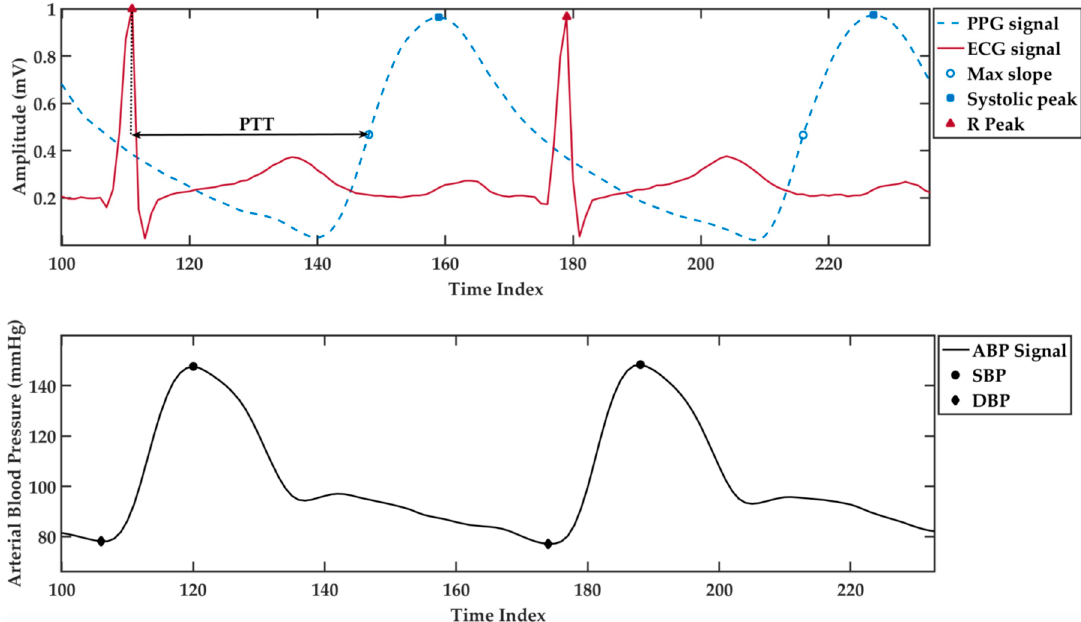
Figure 1. The temporal dependency between the patterns of an electrocardiogram (ECG), photoplethysmogram (PPG), and arterial blood pressure (ABP) signals.